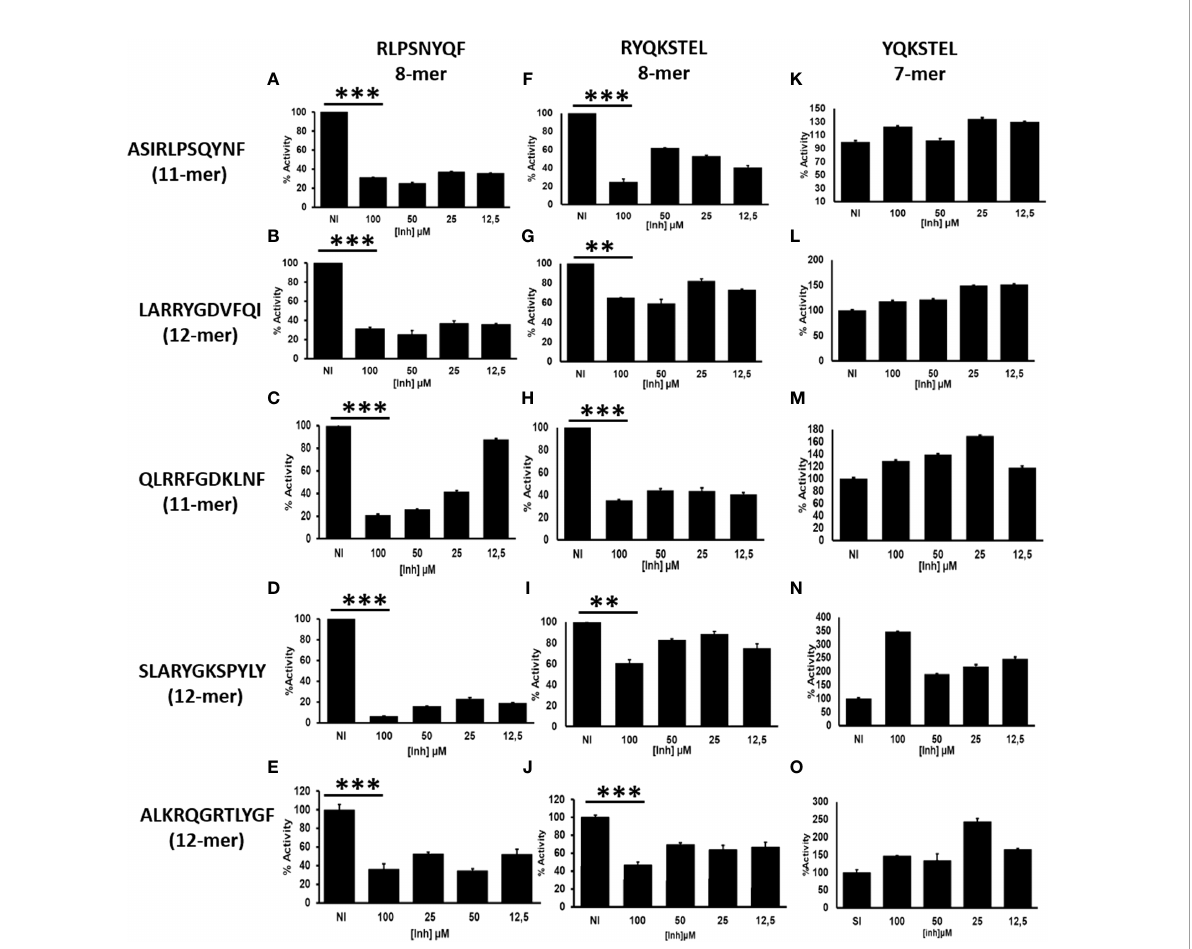
FIGURE 1 ERAP1 activity is inhibited by octamers, not by heptamer: (A) , ERAP1 was incubated with the indicated N-terminally extended peptides (left) and increasing concentration of octamer peptide inhibitor (Vertical; RLPSQYNF panel (A – E) or RYQKSTEL panel F – J ), NI (No Inhibitor). (B) , The N- terminally extended peptides were incubated with ERAP1 in the presence of increasing concentration of heptamer (YQKSTEL) panel (K – O) . Trimming reactions were performed for 32 minutes at an E: S ratio of 1:10 and percent enzyme activity was calculated relative to the quantity of fully trimmed product in the NI reaction. Average and SD for each reaction were derived from three experiment. t-test analysis provided statistical signi fi cance for mean comparisons (P < 0.05). *** extremely signi fi cant, ** very signi fi cant and * signi fi